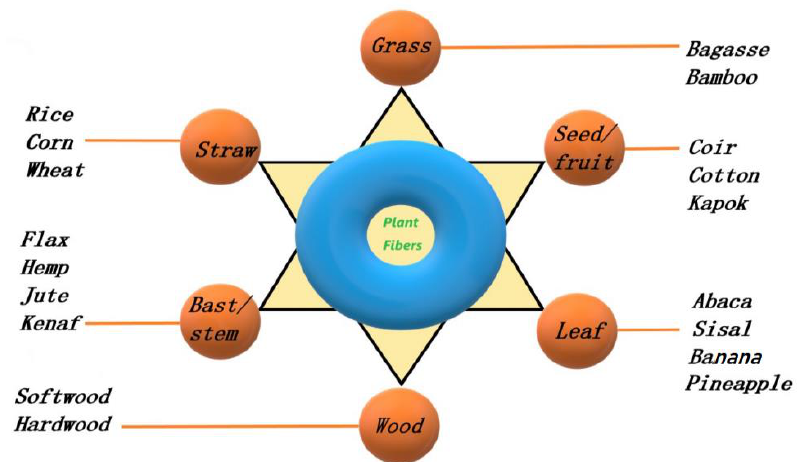
Figure 1. Classification of commonly used